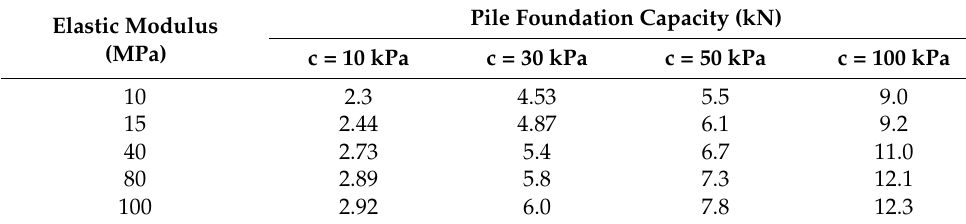
Table 6. Pile foundation capacity in relation to Young’s modulus of soil for CHSB 0 pile.